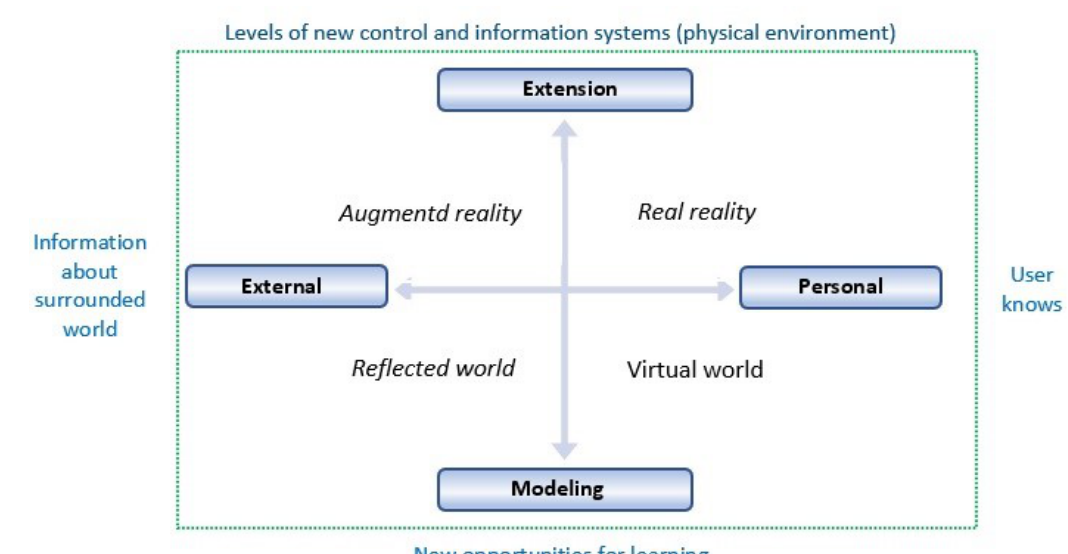
Figure 1: World representation in the synthetic environment (by [32]).